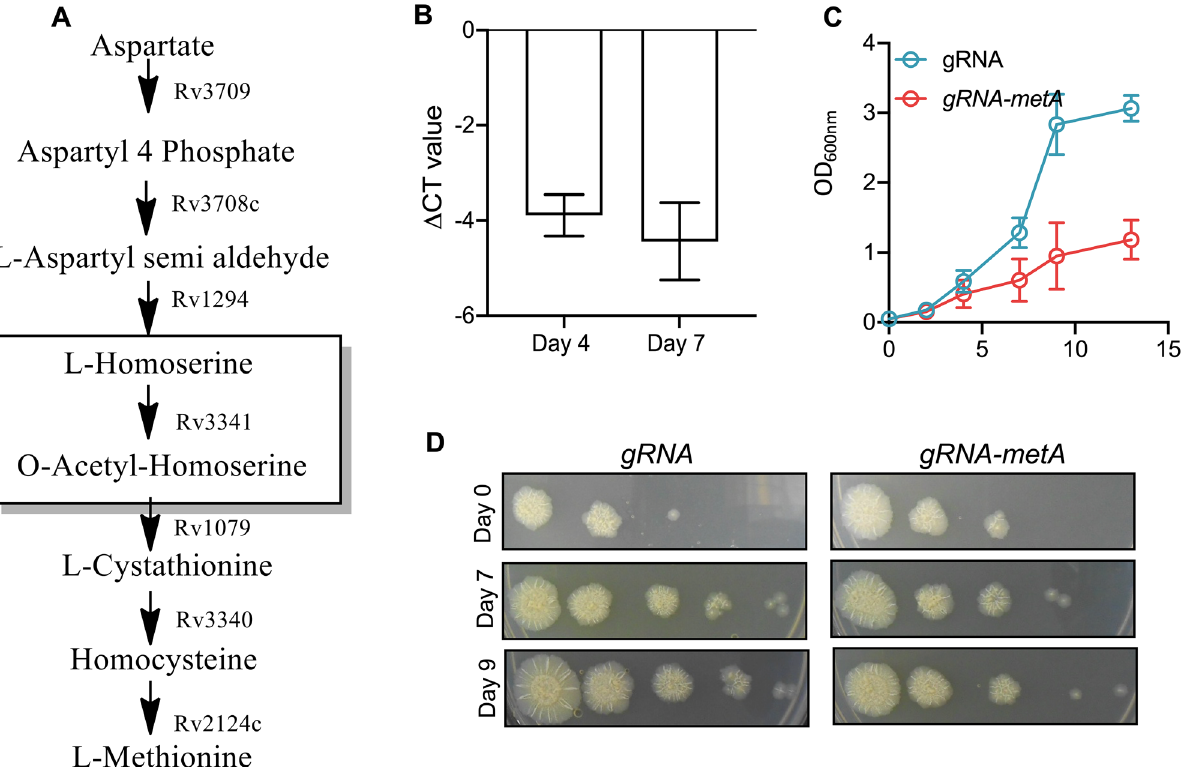
Figure 1. ( A ) Schematic representation of L-methionine biosynthetic pathway in M. tuberculosis . The enzymes involved in L-methionine biosynthetic pathway of M. tuberculosis are shown. Rv3341, highlighted in the box encodes for homoserine acetyl transferase that catalyses the first committed step in L-methionine biosynthesis. ( B ) Silencing of Rv3341 expression in M. tuberculosis using CRISPRi approach. The effect of CRISPRi on metX expression in knock down strain was quantified by qPCR using gene specific primers. The data shown in this panel is mean ± S.E. fold change of ΔCT obtained from two experiments performed in duplicates ( C , D ) Effect of metX repression on M. tuberculosis growth in vitro. The effect of conditional repression of metX on in vitro growth of M. tuberculosis was determined by measuring absorbance (OD 600nm , C ) at regular intervals. In addition, 10.0 fold serial dilutions of cultures were spotted on MB7H11 plates ( D ). The plates were incubated at 37 °C for 3–4 weeks. The data shown in panel C is mean ± S.E. of OD 600nm values obtained from three independent experiments. The data shown in panel D is representative of two independent